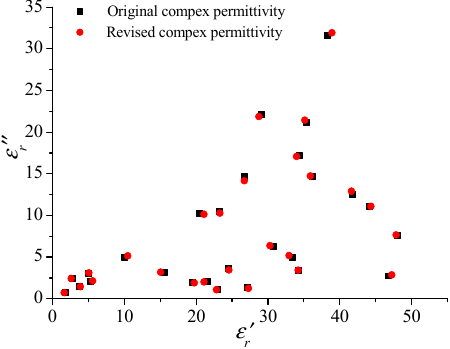
Figure 6. Comparison of the actual and reversed complex permittivity.